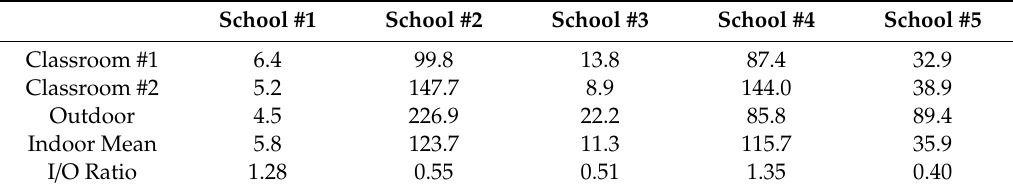
Table 11. PM2.5 Concentration (ug / m 3 ) by